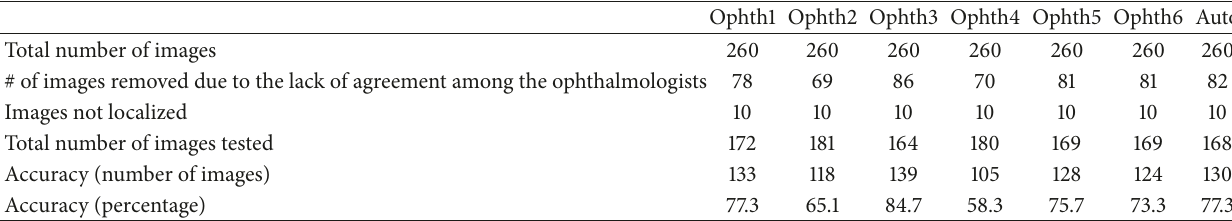
Table 14: The final results for MESSIDOR images